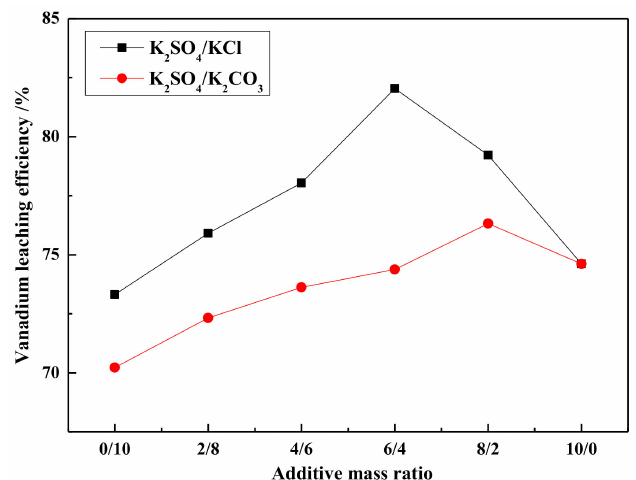
Figure 2. Effect of different composite additives and their mass ratio on vanadium leaching